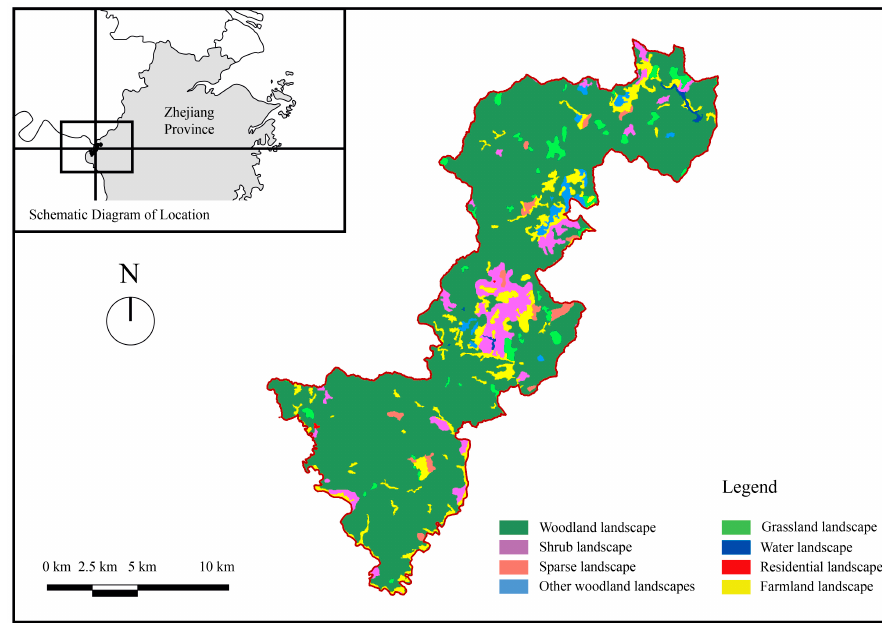
Figure 1. Location and land use status of the study